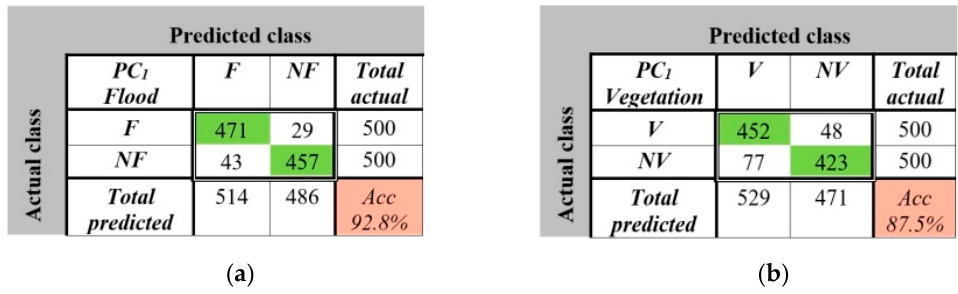
Figure 15. Confusion matrices for flood ( a ) and vegetation ( b ) detection in the case of primary classifier PC 1.